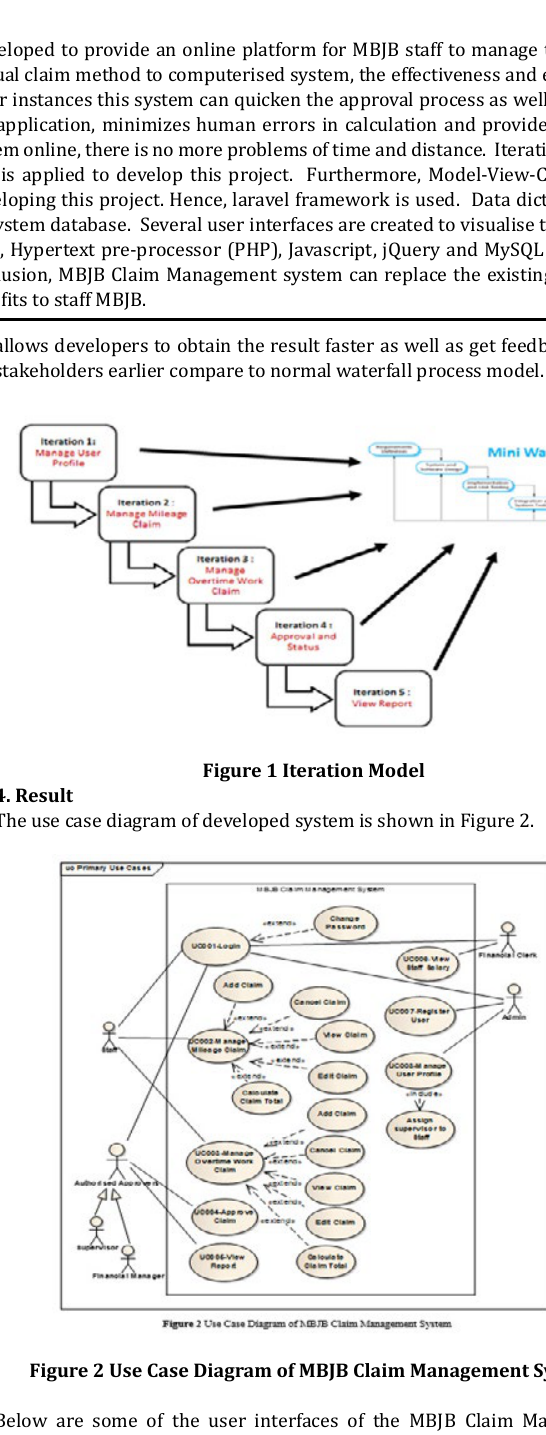
Figure 2 Use Case Diagram of MBJB Claim Management